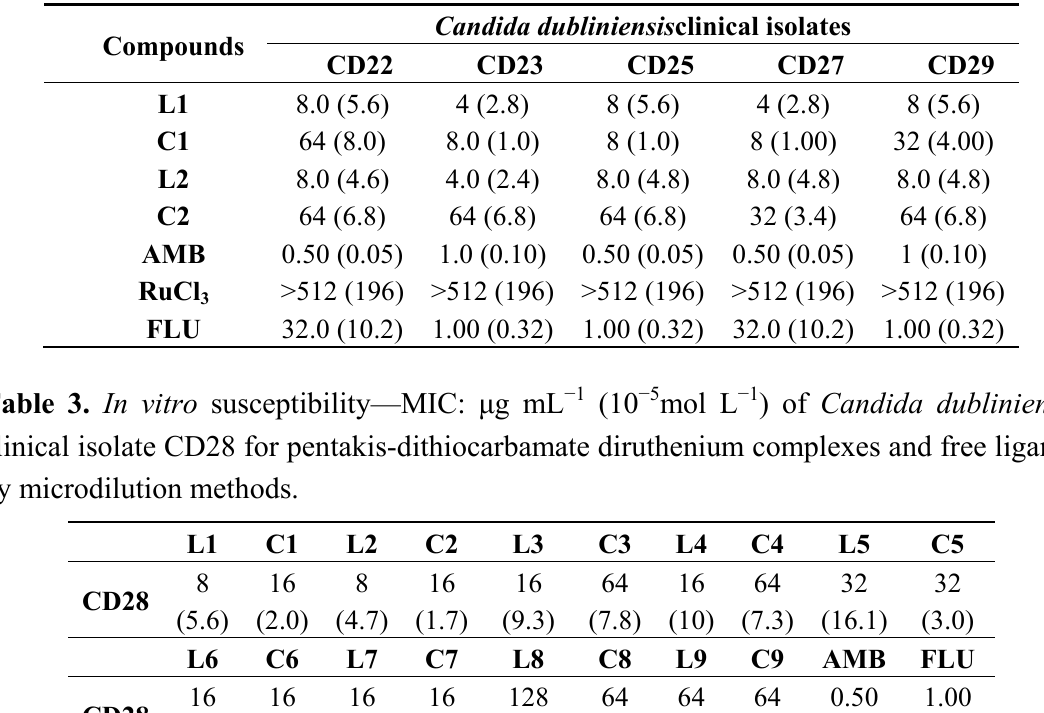
Table 2. In vitro susceptibility of species of Candida dubliniensis clinical isolates for L1 , C1 , L2 and C2 complexes by microdilution methods—MIC: μ g mL − 1 (10 − 5 mol L − 1 ).